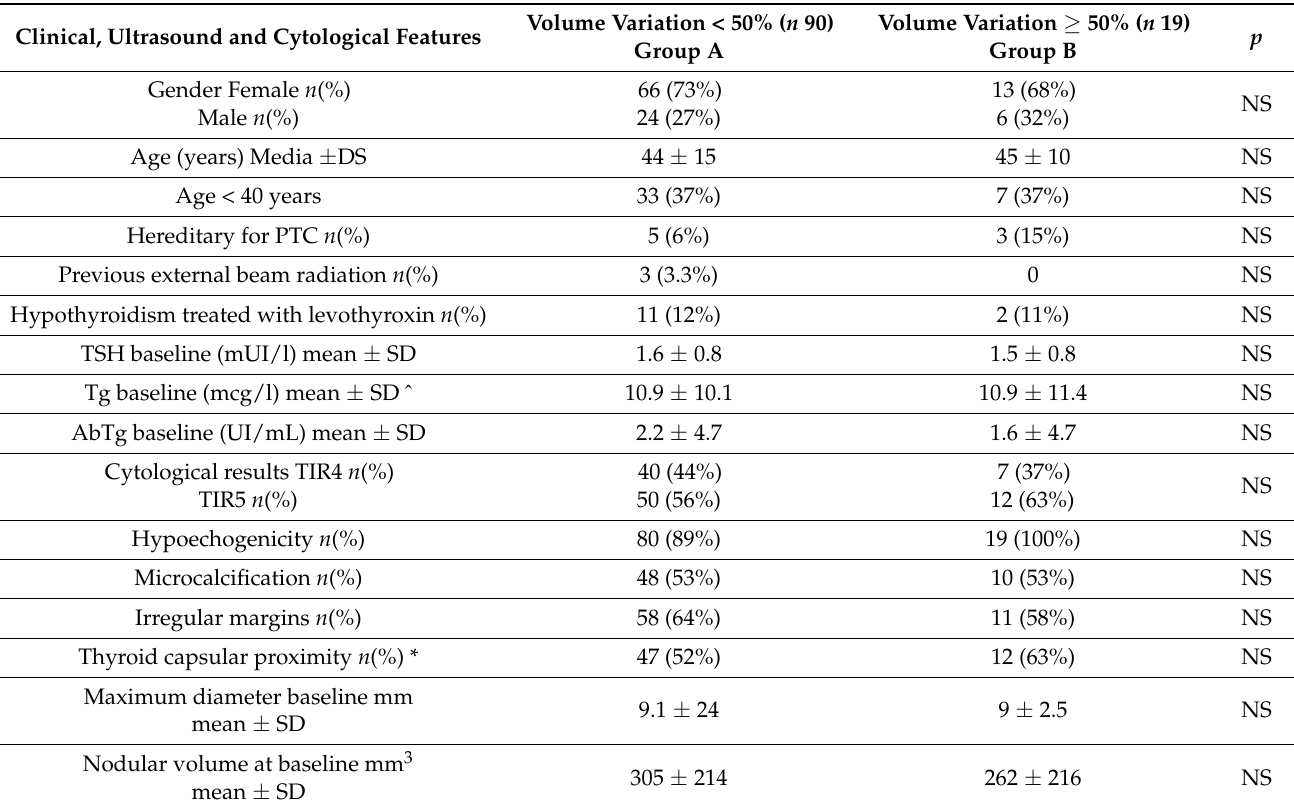
Table 3. Comparison of clinical, ultrasound and cytological features in patients showing less or more than 50% of the volume variation from baseline to last